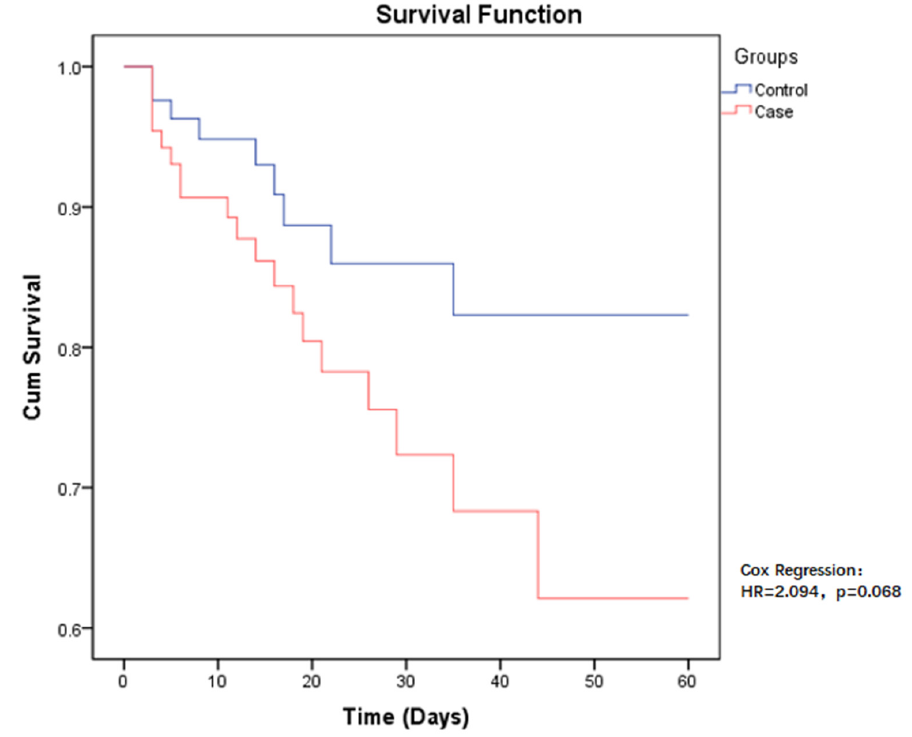
Figure 1. Kaplan–Meier estimates (and 95% confidence limits) of the survival probability of all-cause mortality in CP-CRE (case) and CSE (control) infections, 60-day follow up.